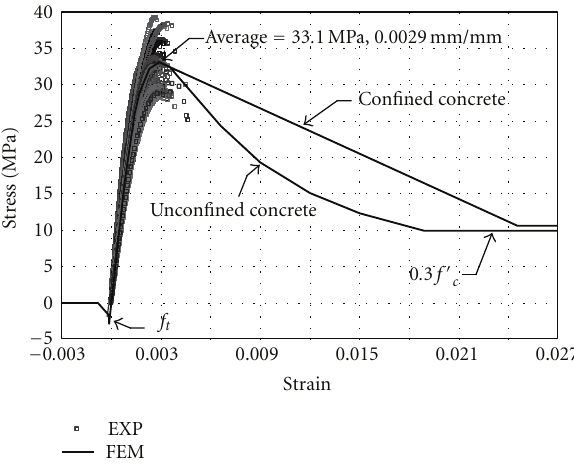
Figure 5: Stress-strain relationship for concrete modeling. of 0.0029 mm/mm, also obtained from the compression tests, was used to construct the concrete stress-strain curve. Tensile strength ( f t ) was set at 0 . 5